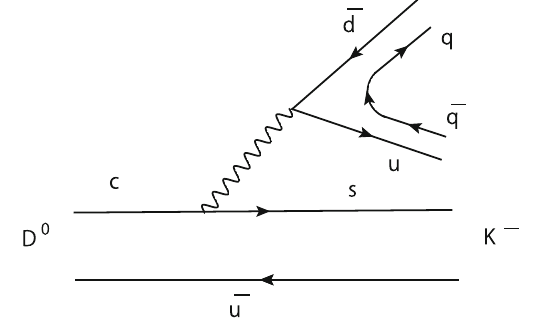
Fig. 2 D 0 decay to ¯ duK − , followed by hadronization of the u ¯ d pair